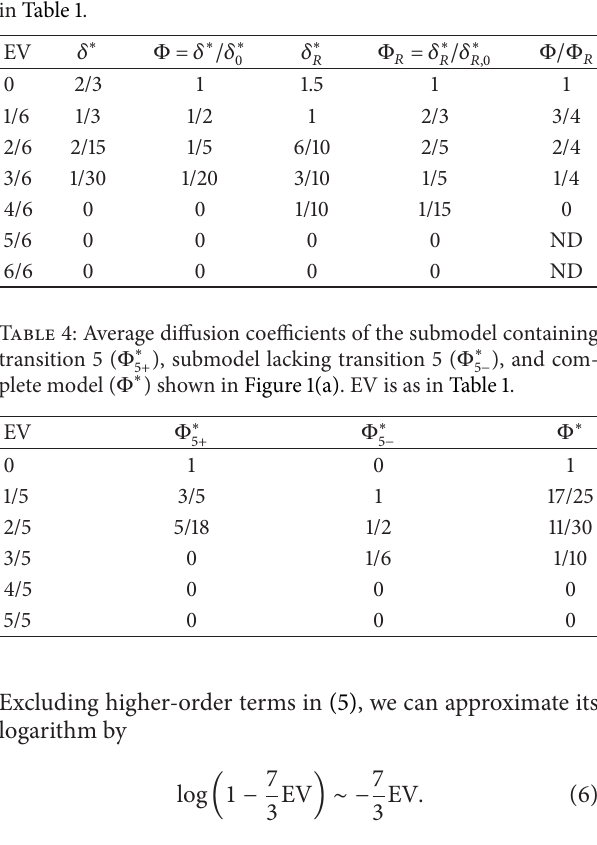
Table 3: Average diffusion coefficients of the model ( 𝛿 ∗ ) and in Table 1.